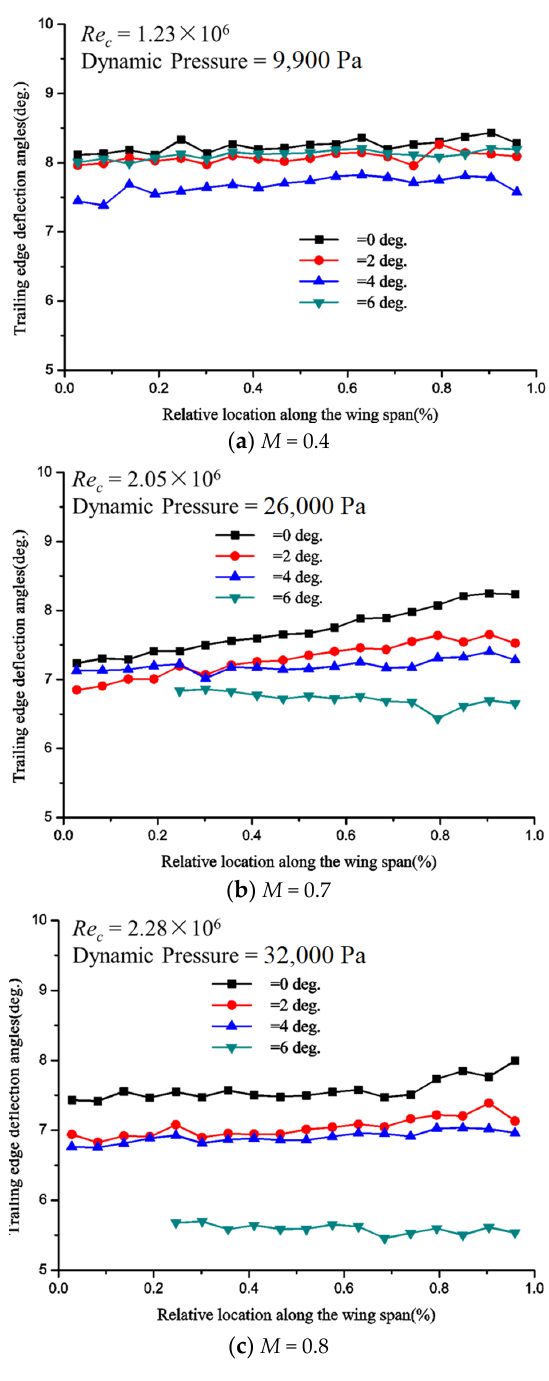
Figure 14. Effect of Mach number on trailing edge deflection ability.